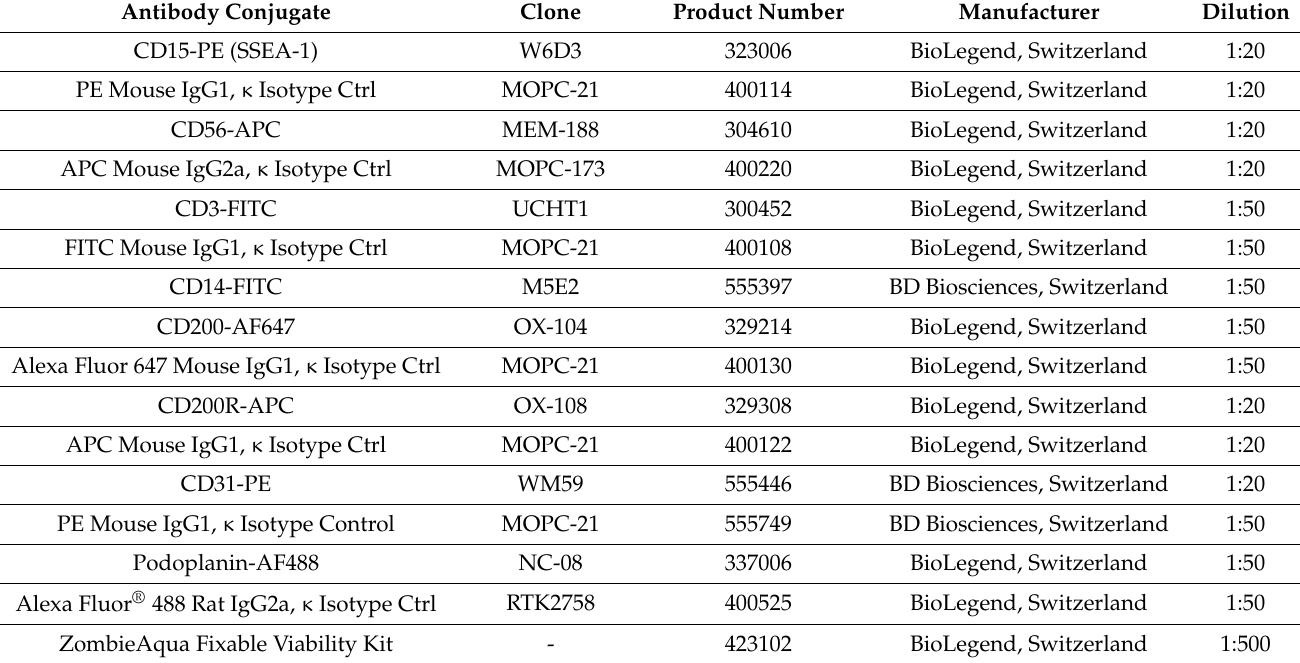
Table 1. Antibody conjugates used in flow